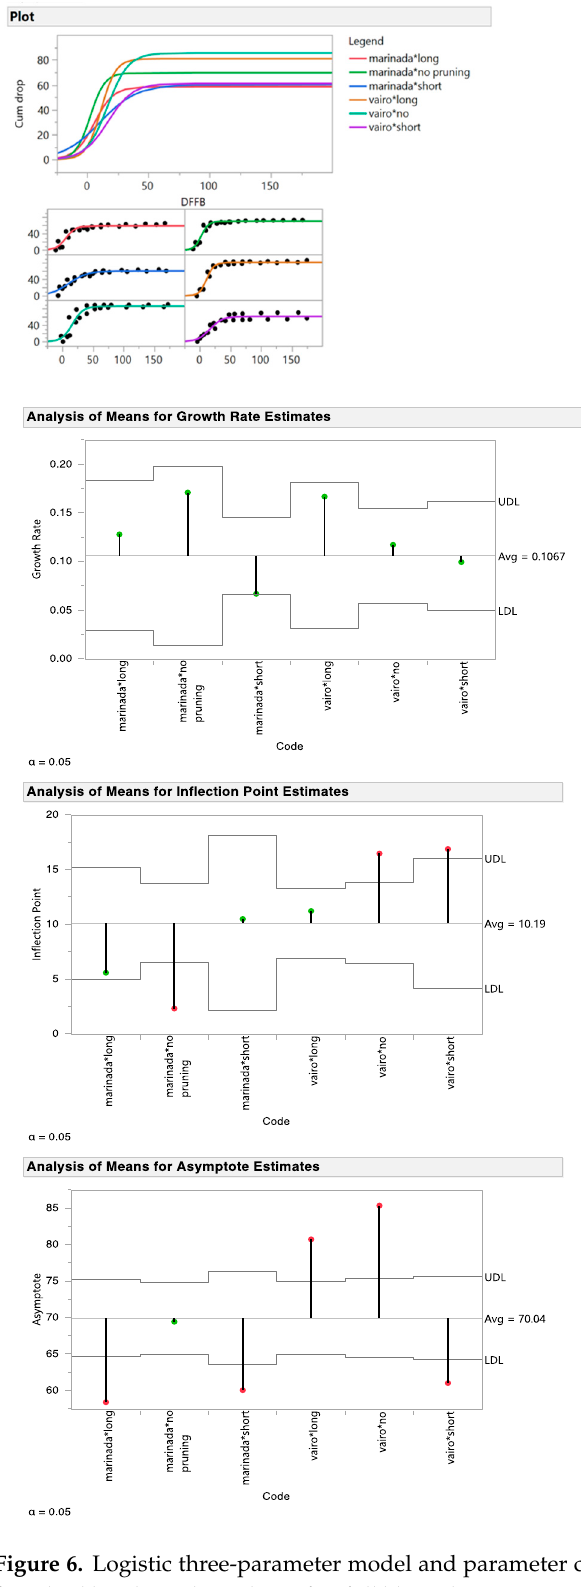
Figure 5. Fitted curves and parameter comparison for the logistic three-parameter models fitted to describe the relationship from bud break until 180 days after full bloom between cumulative fruit drop (%) and days from full bloom (DFFB) for ‘Vairo’ grafted onto Adesoto, INRA GF-677, IRTA 1, IRTA 2, Ishtara ® , Rootpac ® 20, Rootpac ® 40, and Rootpac ® R rootstocks at Les Borges Blanques, Spain (P2). Data were recorded during 2017–2018.